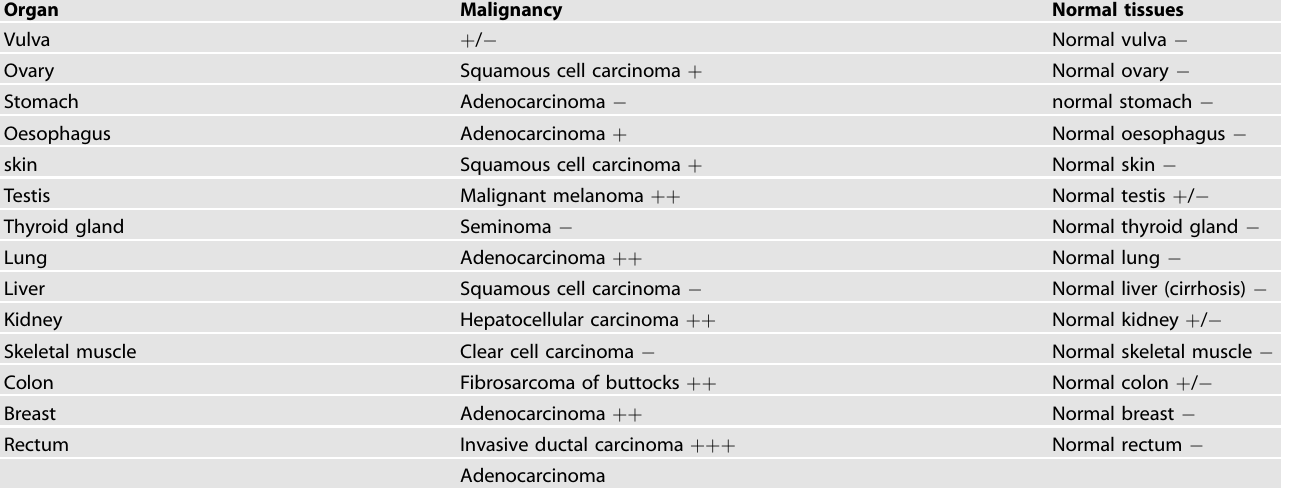
Table 1. Reporter assay detection of YAP1 activation in the different cell